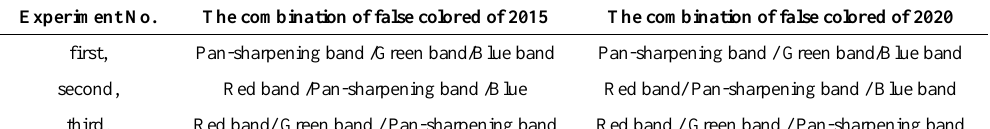
Table 3. The false images of using pan-sharpening bands and the visible bands of 2015 and 2020 Experiment No.